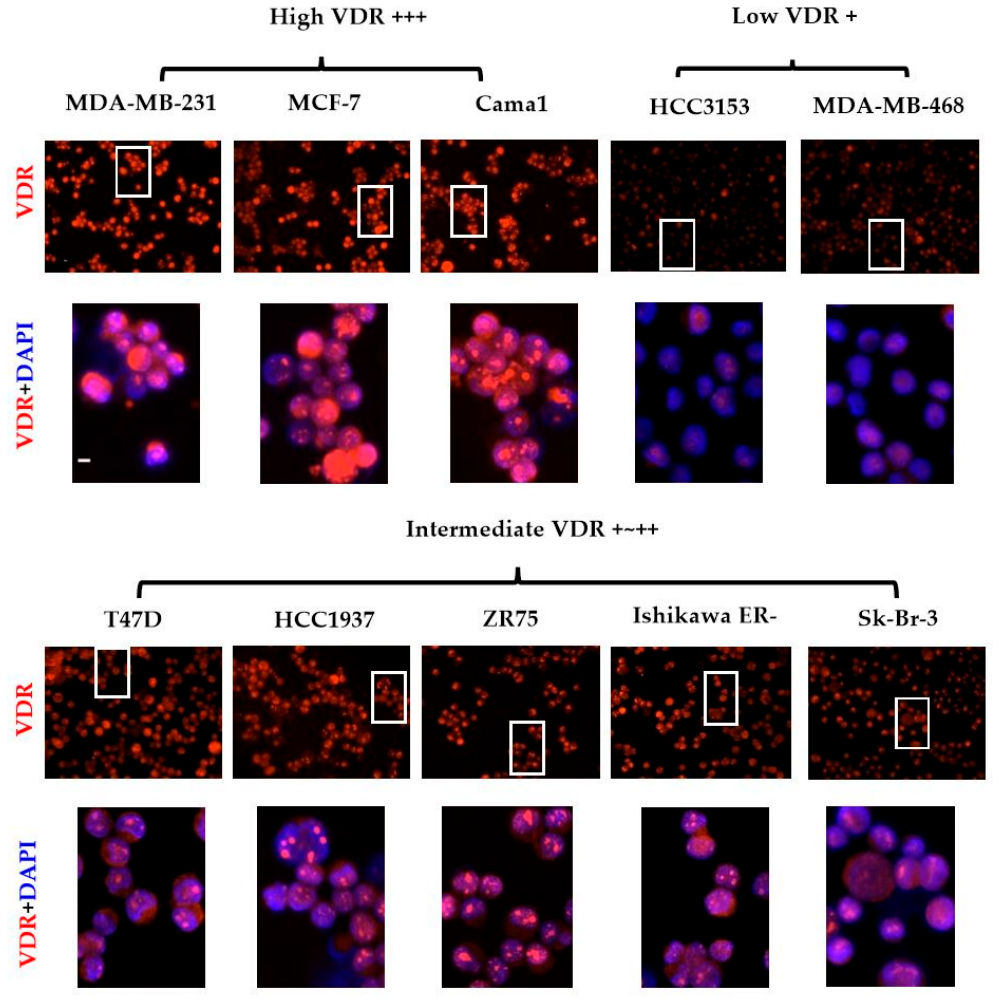
Figure 3. VDR expression in nine BC and one endometrial cell lines. Fluorescence labeling of VDR (in red), CK with DAPI (in blue) nuclear staining was performed on 10 6 cells from 10 cell lines. Various levels of VDR expression were observed, including low (+), average (+~++), or high (+++) levels. Photographs presented are representative of five independent reproducible experiments. Original magnification, × 40. Scale bar (white bar in the upper left image), 10 µ m. BC: breast cancer. Table 1. ER, progesterone receptor (PR), HER2, and VDR expression levels of the nine BC and one endometrial cell lines.